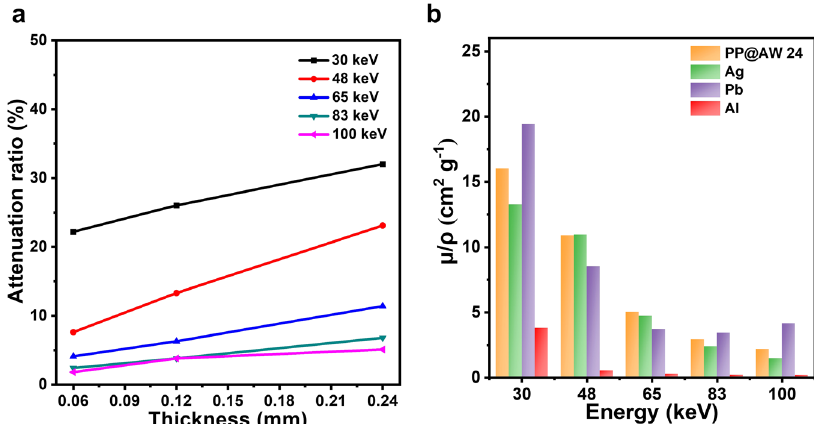
Fig. 3 X-ray shielding properties. a X-ray attenuating properties of PP@AW24 membranes with respect to thickness. b Comparison of mass-attenuation coef fi cients of PP@AW24 membranes (0.24 mm thickness) and Ag, Pb, and Al foils (0.15 mm